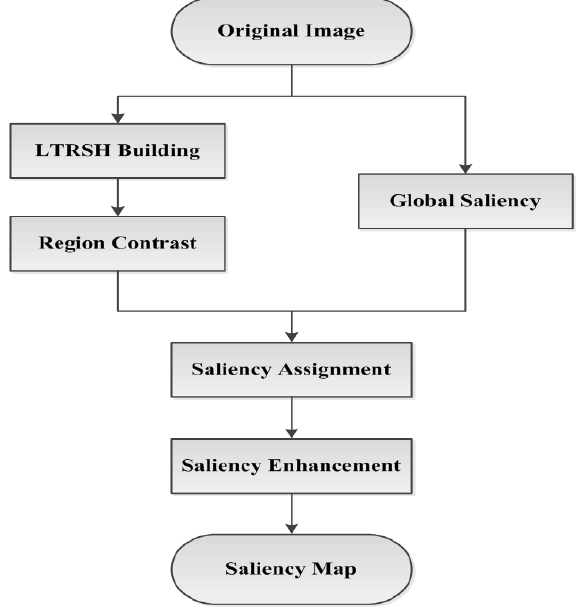
Figure 3. The scheme of our